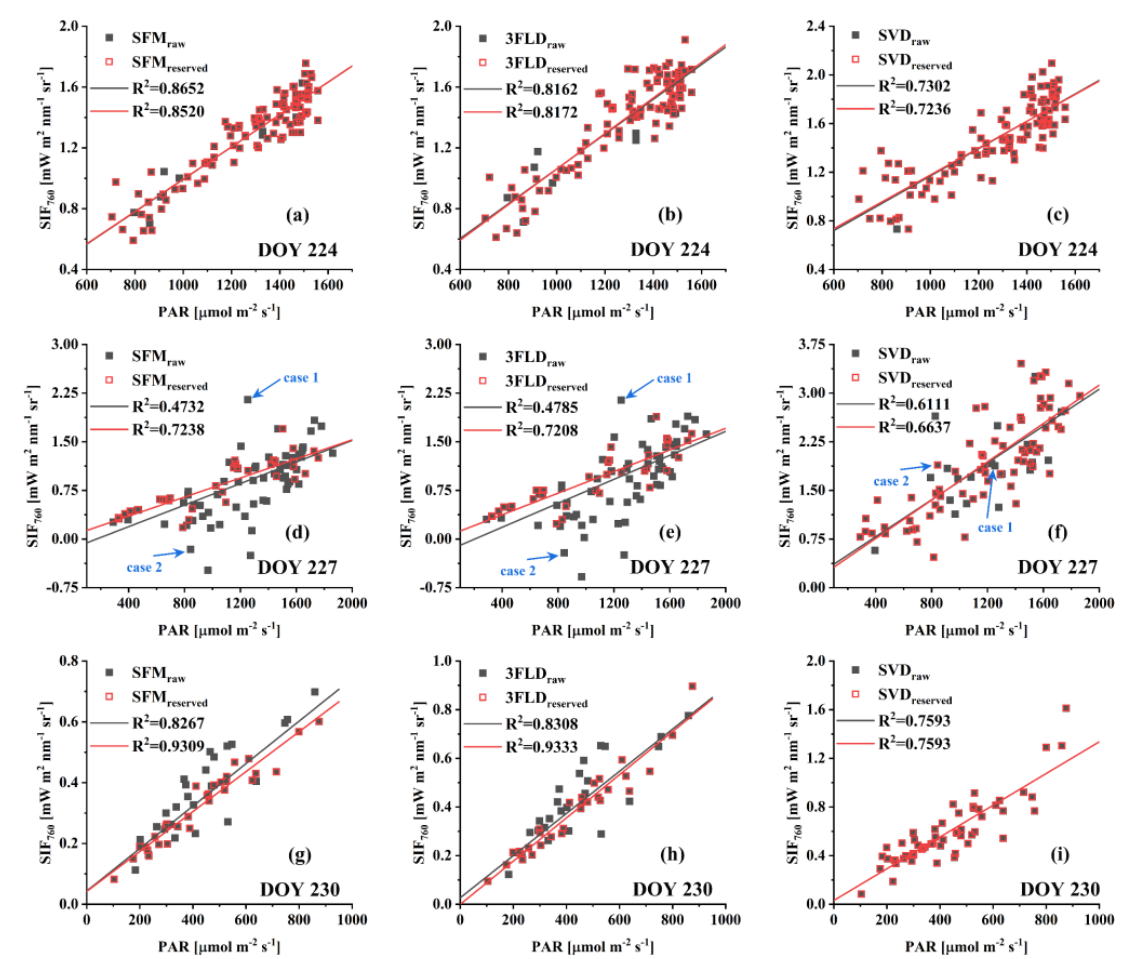
Figure 7. The relationship between PAR and SIF retrieved by the SFM, 3FLD, and SVD methods under three sky conditions: ( a – c ) for the clear day (DOY 224); ( d – f ) for the rapidly fluctuating illumination condition day (DOY 227); and ( g – i ) for the cloudy day (DOY 230). Black square dots represent the retrieved SIFs at 760 nm by SFM, 3FLD, and SVD. Red square circles represent the reserved SIF. The PAR values were the average of the high-frequency PAR values during the L measurements.